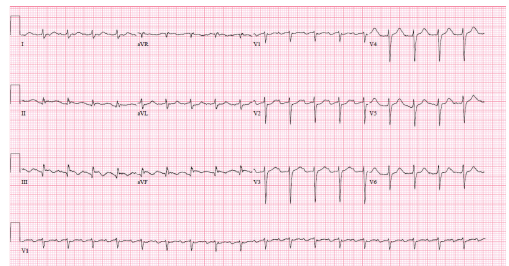
Figure 1: EKG at the time of admission shows sinus tachycardia and inferior myocardial infarction, age undetermined. This EKG also shows a prolonged QTc interval.